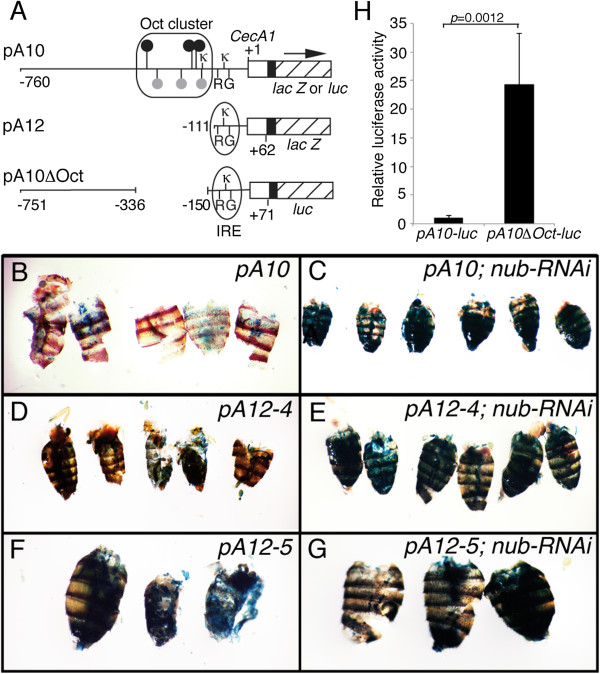
A distal promoter region of CecA1 is required for Nub-PD-dependent repression. (A) Schematic representation of the CecA1-lacZ and CecA1-luc constructs, either carried by transgenic Drosophila or used for cell transfections. The pA10 construct contains 760 or 751 bp of 5′ upstream region from the CecA1 gene (horizontal line), and 62 or 71 bp of 5′ UTR (open box) fused to a SV40 leader (filled box), providing a translational start site in frame with the Escherichia coli lacZ or luc coding sequence (hatched box) [7,41]. Numbers refer to positions relative to the transcription start site (+1). Location of regulatory sequence motifs, as indicated by symbols and letters, is in scale. A previously characterized infection-induced response element (IRE) contains a κB-like site (κ), GATA site (G) and R1 site (R), and one additional κB site is located just 5′ of the IRE. A cluster of Oct sequence motifs (rectangle) contains several consensus Oct sequences (black circles) and Oct-like (gray circles) sequences (see Additional file 11 for sequences and exact locations). The pA12 construct contains 111 bp of 5′ sequence including the IRE, but not the Oct cluster. The pA10∆Oct-luc construct has an internal deletion of the whole Oct cluster (−336 to −150) but is otherwise identical to the pA10-luc construct. (B-G)CecA1-driven β-gal staining in the fat body of abdomens from flies carrying either the pA10 construct (pA10 CecA1-lacZ / TM3) (B,-C) or the pA12 construct (pA12 CecA1-lacZ) (D-G). Two independent transgenic lines, pA12-4 (D,E) and pA12-5 (F,G) were used. (H) Transfection of mbn-2 cells with CecA1-luc constructs confirms that the Oct cluster region is involved in repression of the CecA1 promoter. The graph shows the mean values of relative luciferase activity and standard deviation (n = 6). Statistical significance was calculated using paired t-test, P = 0.0012.